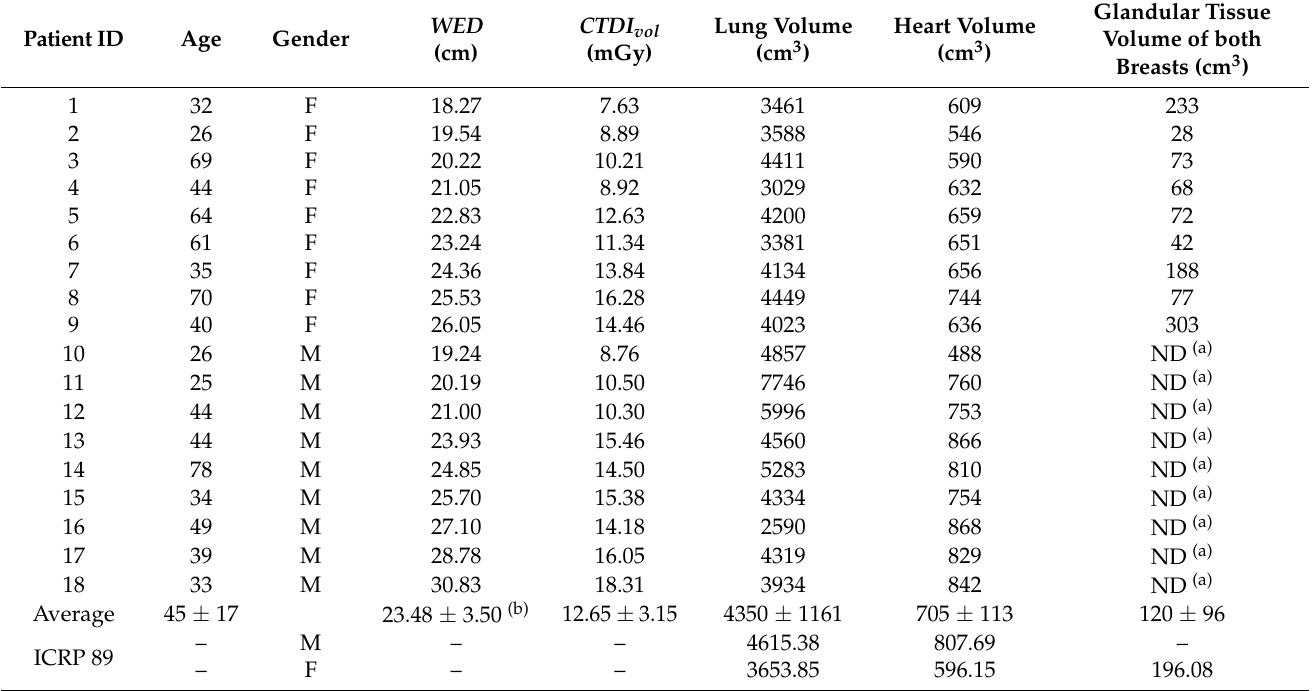
Table 1. The WED , CTDI vol , and organ volumes for 18 patient models used in this